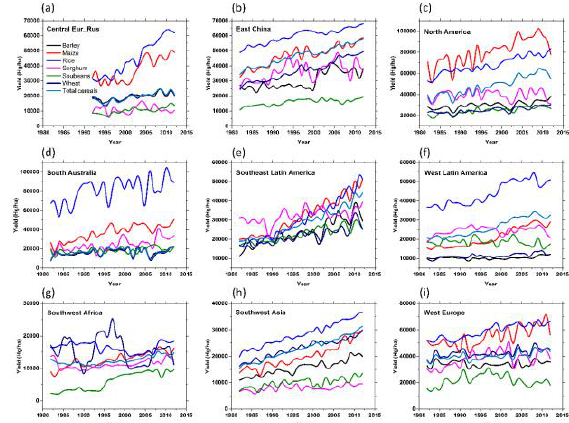
Figure 3. Annual yield change trend of seven main crops in nine major crop zones.